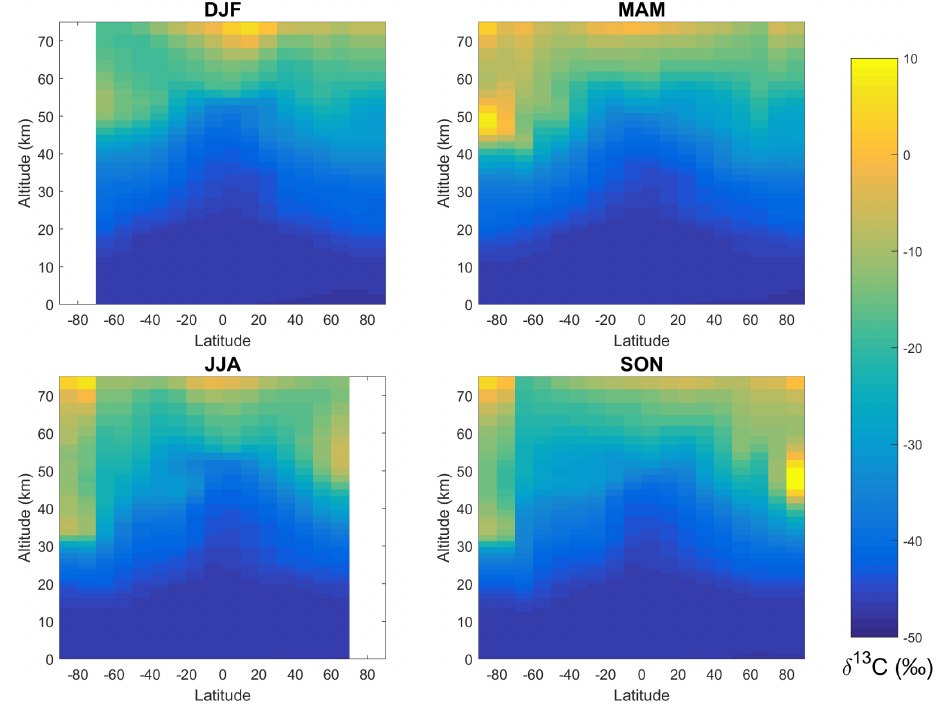
Figure 8. δ 13 C by season from the ACE-sampled WACCM data